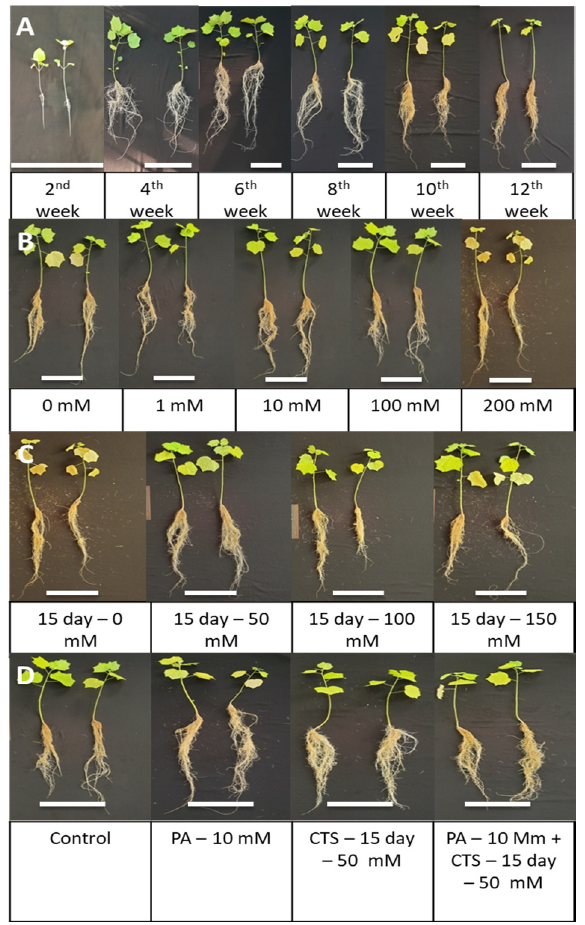
Figure 8. AHR phenotypes were cultured and affected by various treatments with PA and CS. ( A ) AHRs culture at 12 weeks. ( B ) Comparison of growth with various PA concentrations. ( C ) Comparison of growth with various CTS and ET. ( D ) Comparison of individual and synergistic effects of growth. Scale bar = 20 cm.